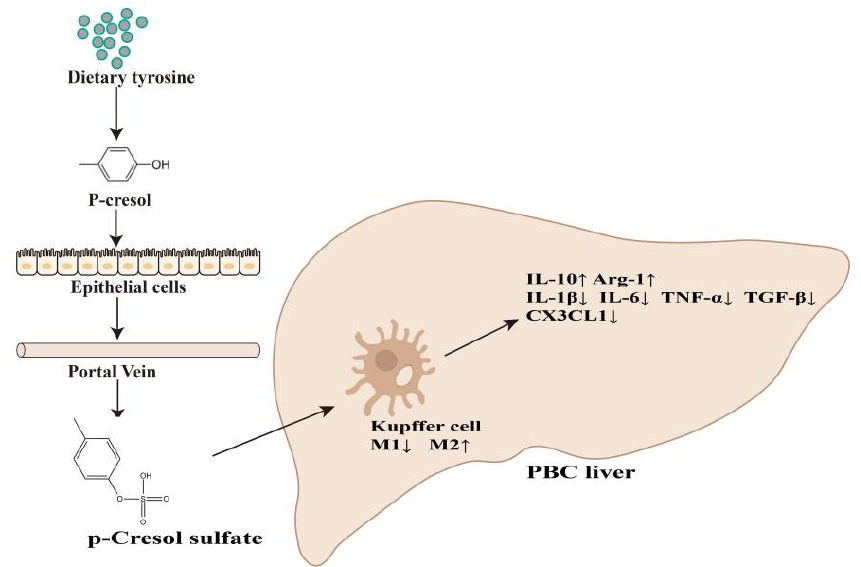
Figure 7. Potential mechanism of PCS-mediated alleviation of PBC inflammation. PCS reduces levels of proinflammatory factors (IL-1β, IL-6, TNF-α, TGF-β, and CX3CL1), increases the level of the anti-inflammatory factor IL-10, Arg-1, and alleviates PBC-related inflammation by changing the polarization of Kupffer cells.